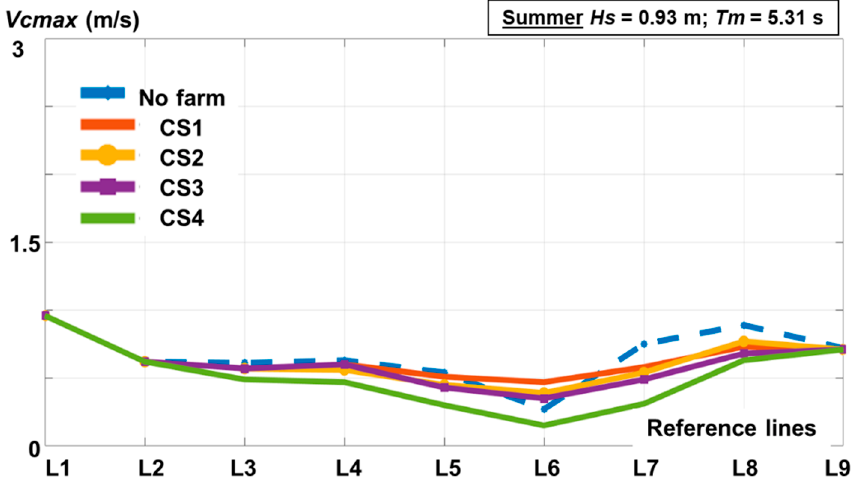
Figure 11. Maximum values of the nearshore current velocities along the reference lines considered. The results correspond to an energetic summer event (Summer A).